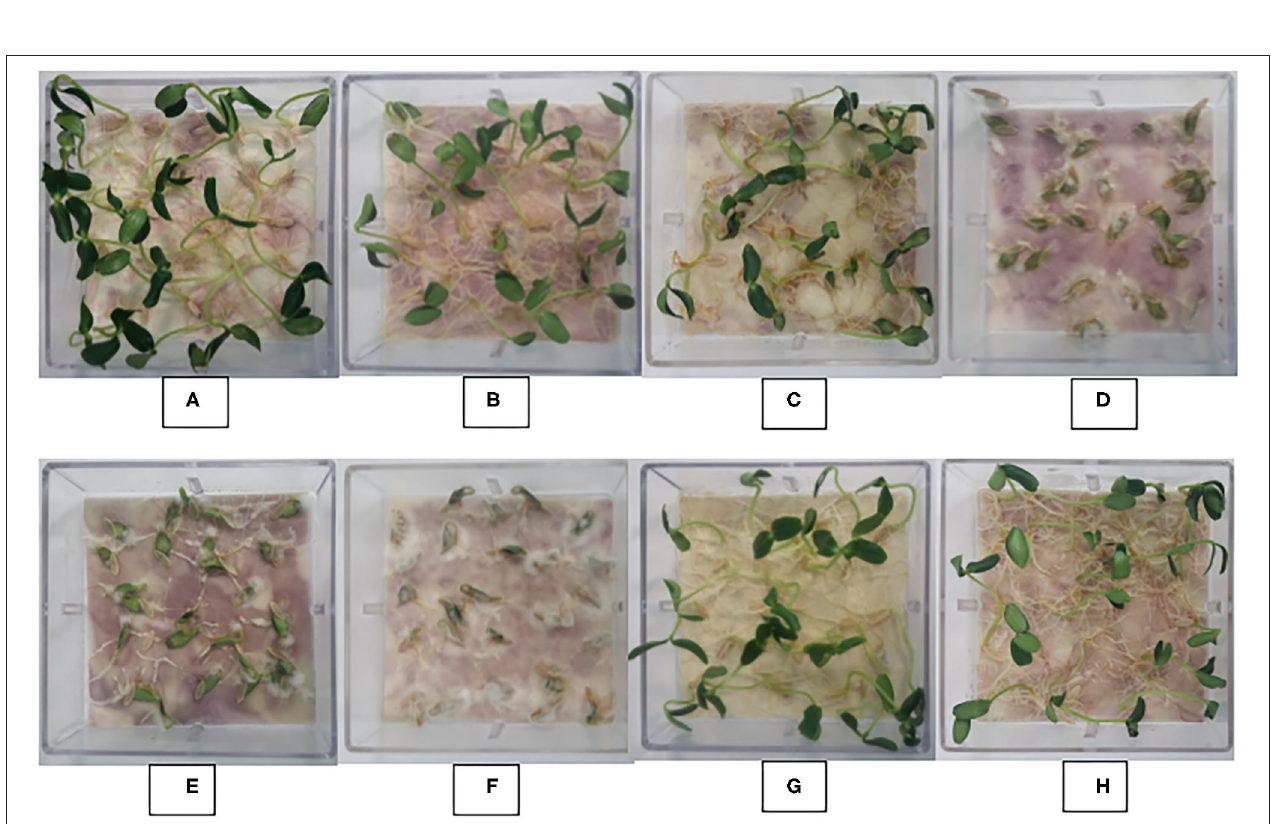
FIGURE 5 | Visualization of the growth of biocompounds that presented satisfactory results of bioherbicidal effect in Cucumis sativus . (A) Biocompound E2; (B) Biocompound E11; (C) Biocompound E16; (D) Biocompound E1; (E) Biocompound E9; (F) Biocompound E13; (G) Biocompound E7; (H) Biocompound